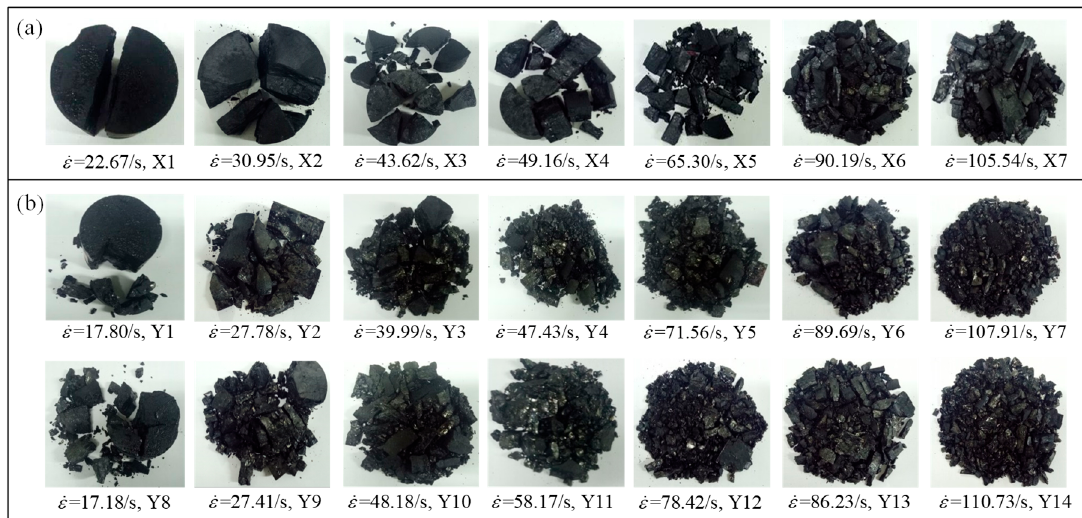
Figure 6. Fragment distribution of crushed coal in uniaxial compressive SHPB tests at different strain rates: ( a ) Xinzhouyao specimens (resistant), ( b ) Xintian specimens (prone).